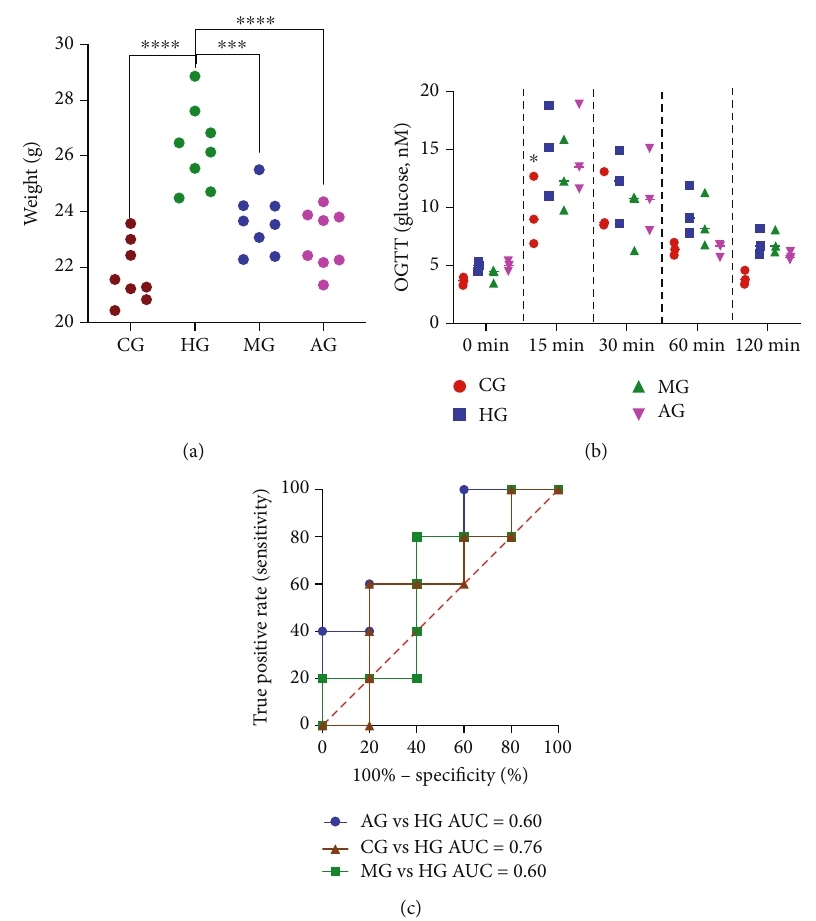
Figure 2: The e ff ects of Kluyveromyces marxianus on mouse weight and glucose tolerance. (a) The weight of the mice. n = 8 for each group. (b) An oral glucose tolerance test (OGTT) for glucose tolerance. n = 3 for each group. (c) The area under the ROC curve (AUC) of OGTT. ∗∗ P < 0 : 01 , ∗∗∗ P < 0 : 001 , and ∗∗∗∗ P < 0 : 0001 vs. the HG